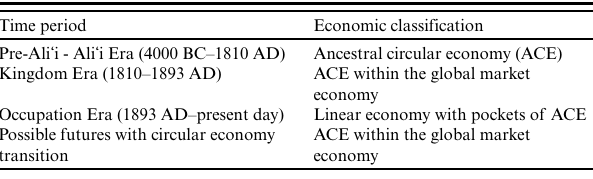
Table 1. Time periods in Hawai ʻ i with corresponding economic